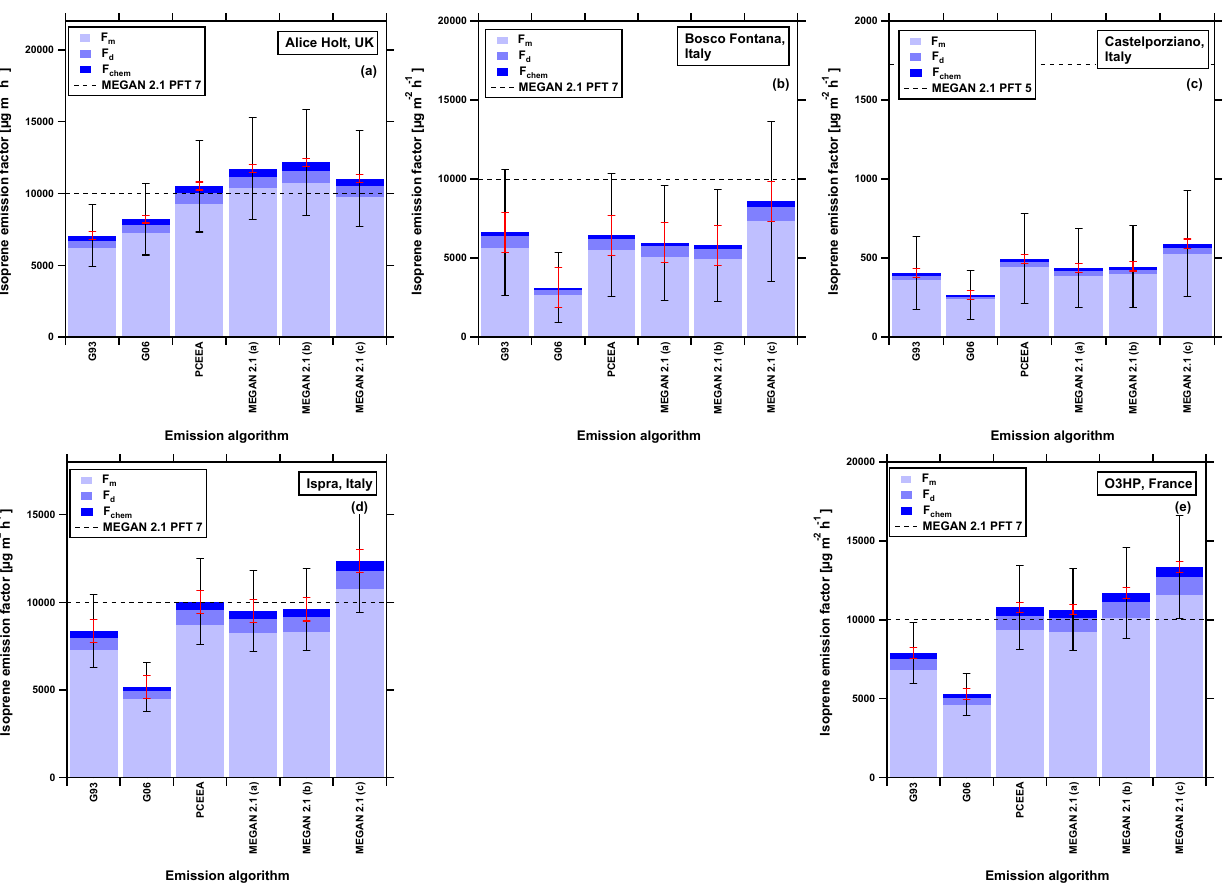
Figure 5. Graduated bars representing an oak-specific isoprene emission potentials ( ε can ) at each of the five measurement sites. Each bar shows (i) the calculated emission potential based on measured fluxes ( F m ) , (ii) the correction applied for dry deposition ( F d ) and (iii) the correction applied for chemical flux divergence ( F chem ) . For each site emission potentials were calculated using six implementations of the Guenther algorithms (see Sect. 2.2 for details) and are shown relative to the relevant plant functional type emission potential in MEGAN 2.1 (black line). The red error bars show the uncertainty in the emission potential that relates to the random error in the observed flux measurements. The black error bars show the total uncertainty (random and systematic errors). MEGAN 2.1 (a) is the full implementation of the model using calculated leaf temperature. MEGAN 2.1 (b) is the full implementation of the model using air temperature. MEGAN 2.1 (c) is a version of the model where only the effects of current environmental conditions (e.g. light and air temperature) are